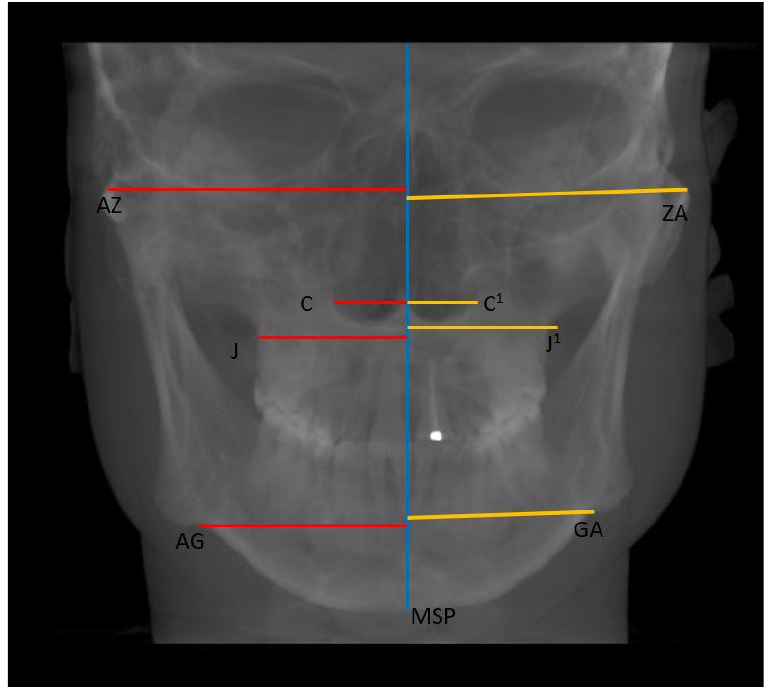
Figure 6. Asymmetry measurements on the MSP (Midsagittal Plane).